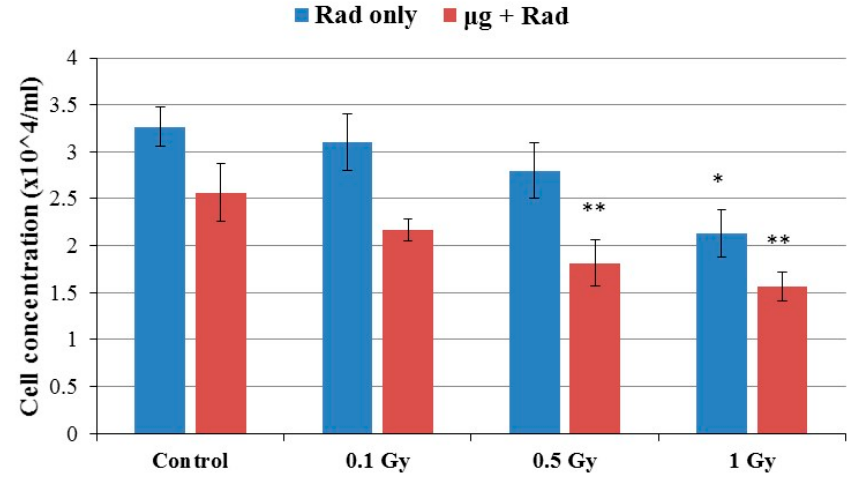
Figure 1. Concentration of RAW264.7 cells after exposure to different radiation doses. The number of cells decreased with increasing radiation doses. Cells previously cultured under simulated microgravity grew significantly slower (two-way ANOVA: p < 0.0001). Error bars mean standard deviation (SD) from three replicates. One-way ANOVA: p = 0.0038 for radiation only and p = 0.0026 for radiation + microgravity. Stars mean Dunnett’s multiple comparison test: * p < 0.05 and ** p < 0.01, compared to the corresponding control.